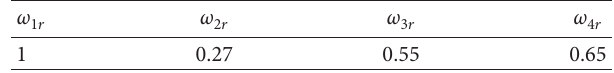
Table 10: Overall dominance degrees.